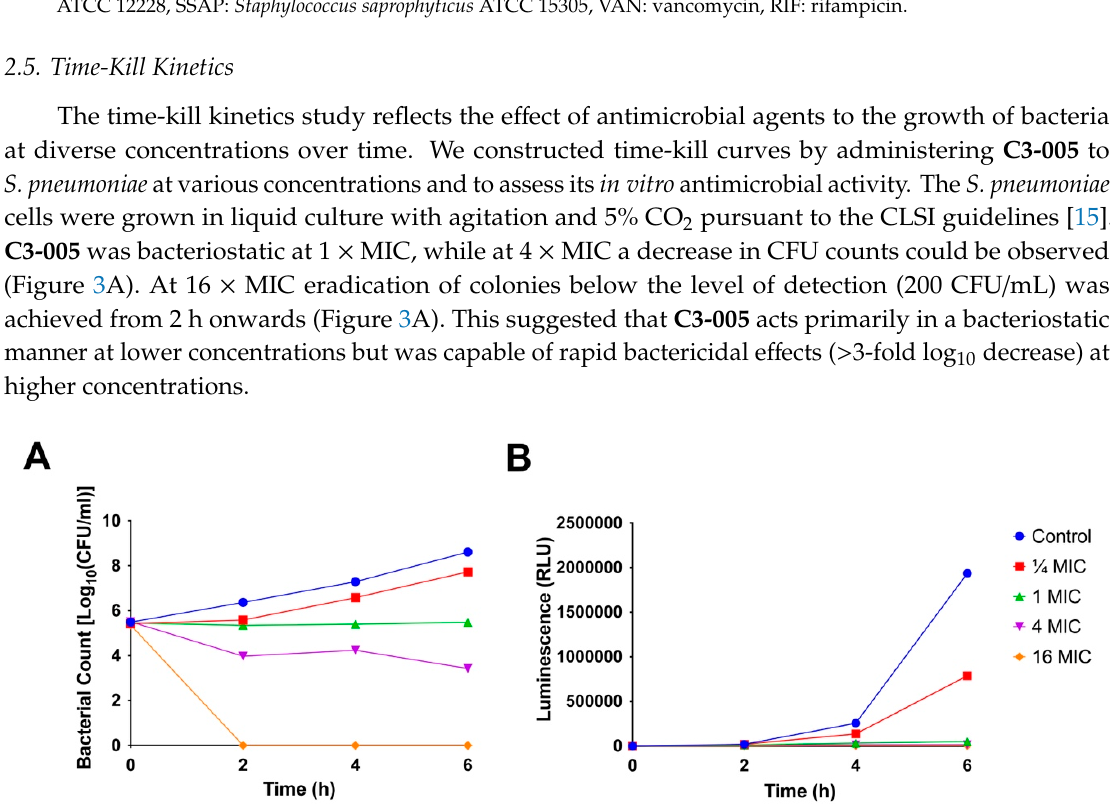
Antimicrobial activity (MIC µ g / mL) of C3-005 against representative Gram-positive bacterial pathogens. Compound